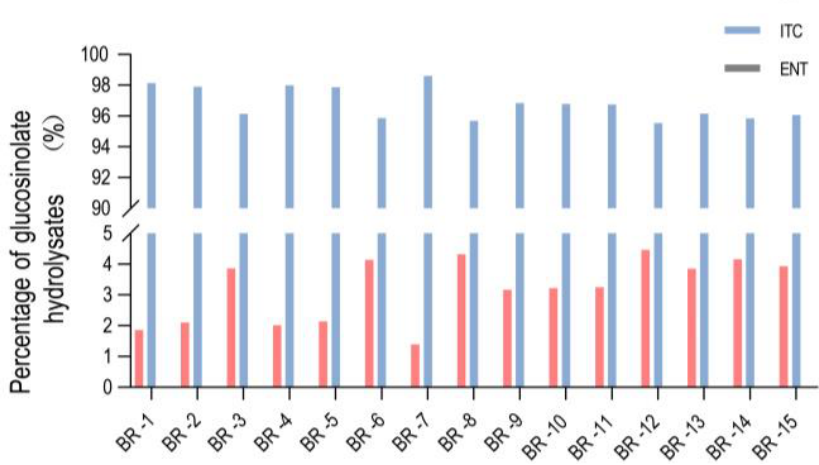
Figure 6. Proportion of glucosinolate metabolites in Chinese cabbage.